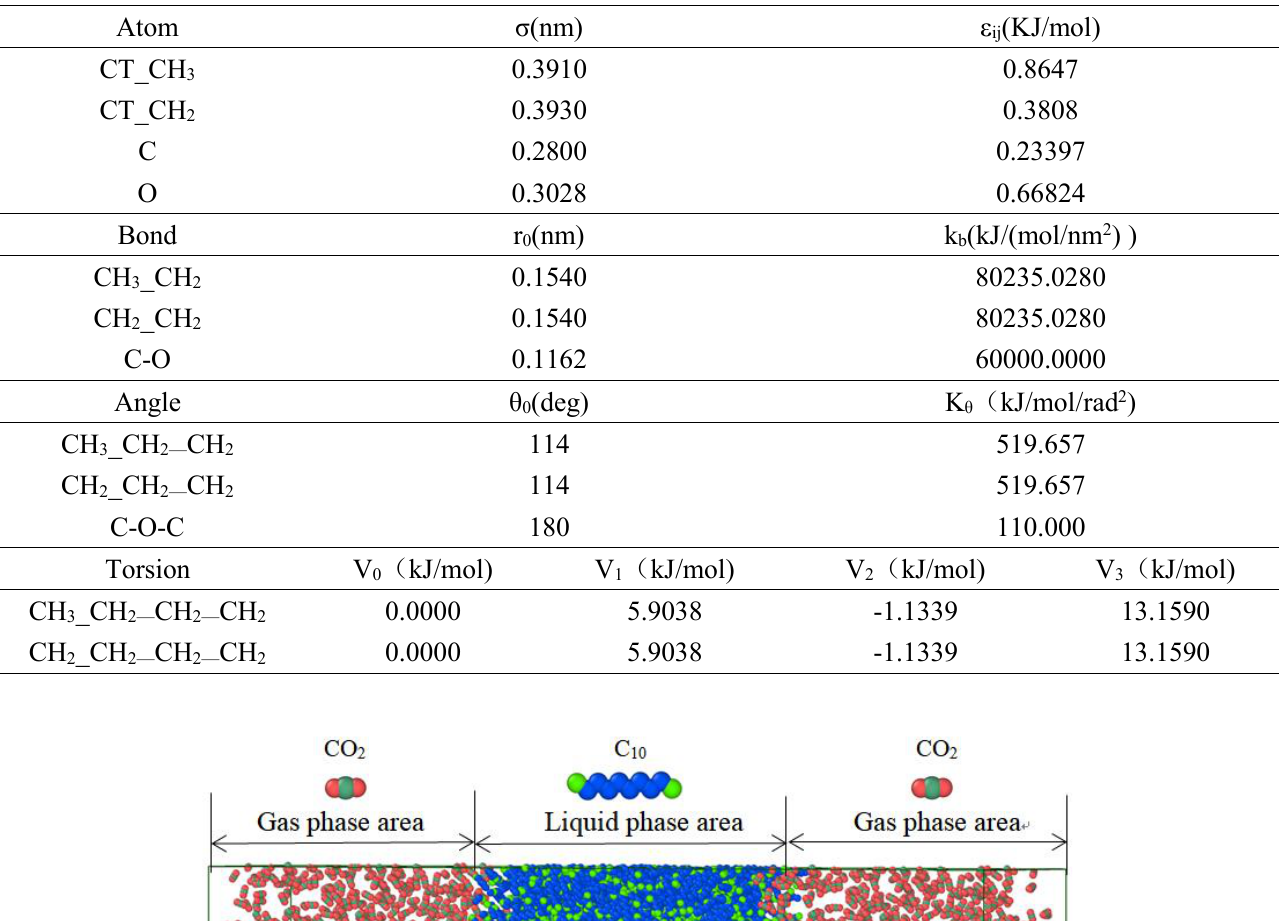
Table 1 — Force field parameters.